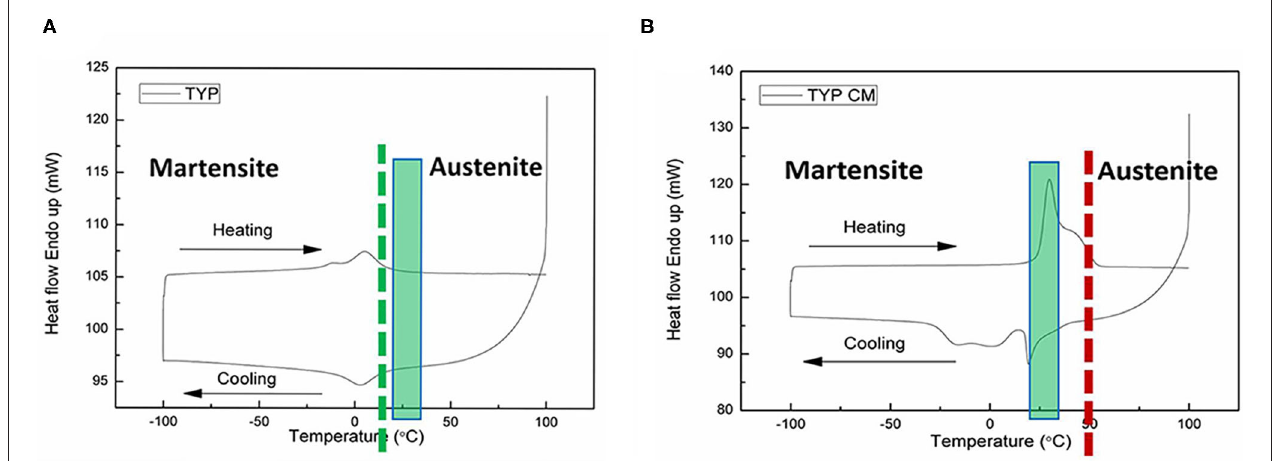
FIGURE 1 | Differential scanning calorimetry curves of nickel–titanium (NiTi) instruments. The austenite-finish (A f ) temperature shown with blue dotted line is 17 ◦ C for a “conventional” superelastic NiTi file (A) and 55 ◦ C for heat-treated NiTi file shown with a red dotted line (B) . The blue bar represents the temperature range between room temperature and body